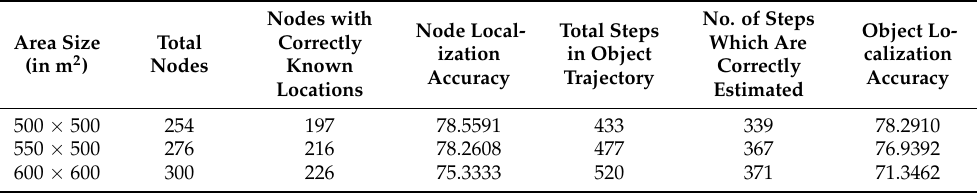
Table 11. Node localization accuracy and object localization accuracy.